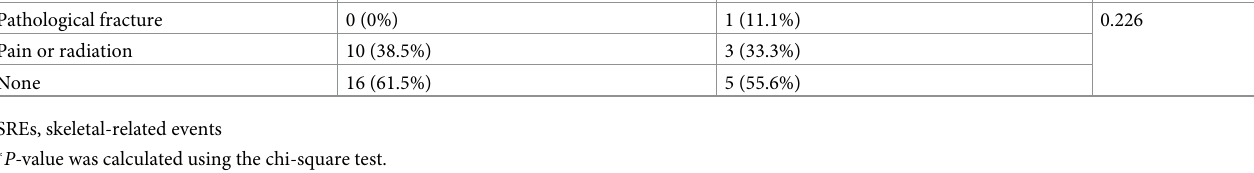
polymorphism of ALDH2 , even though a flushing questionnaire had a sensitivity and specific- ity of approximately 90% for identifying ALDH2-deficient individuals among Japanese women [23, 24]. In the present study, the rate of patients with high sensitivity to alcohol was 14% (45/332). There are two possible explanations for our results: (a) patients with high sensi- tivity to alcohol had the inactive form of ALDH2 encoded by the rs671 polymorphism of ALDH2 , and the other patients had the active form of ALDH2; or (b) patients with high sensi- tivity to alcohol had the inactive form of ALDH2, whereas a small number of ALDH2-deficient individuals were included among patients with low sensitivity to alcohol. Flushing after light drinking may disappear after a long history of drinking alcohol [18, 22]. Those with a long his- tory of drinking may not have noticed their past flushing and received docetaxel with ethanol solution even though they have the inactive form of ALDH2. Thus, a lack of information about patients’ lifestyle, such as alcohol consumption, diet, and oral hygiene, is a limitation of this study. Another limitation is that mild cases of MRONJ may be underestimated. Although the risk of osteonecrosis of the jaw should be evaluated before starting bone-modifying agents